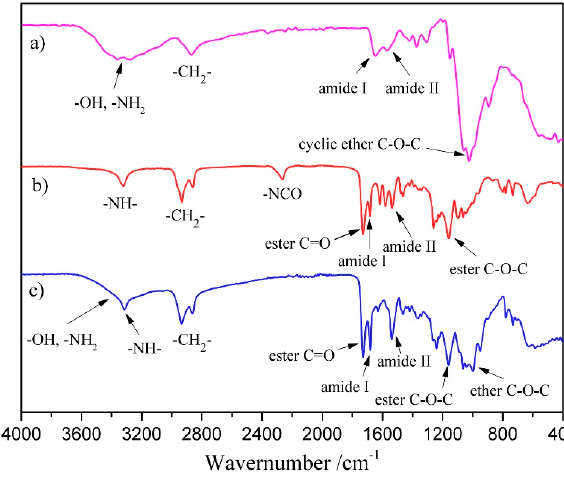
Figure 2. FT-IR spectra of ( a ) COS; ( b ) prepolymer and ( c ) CPU-1.7.